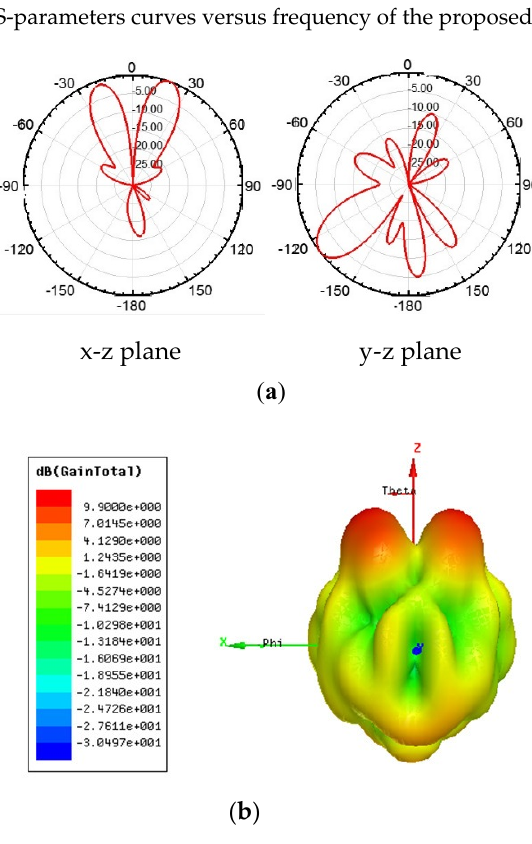
Figure 12. Simulated radiation characteristics of a single patch antenna ( a ) 2-D radiation pattern; ( b ) 3-D radiation pattern.